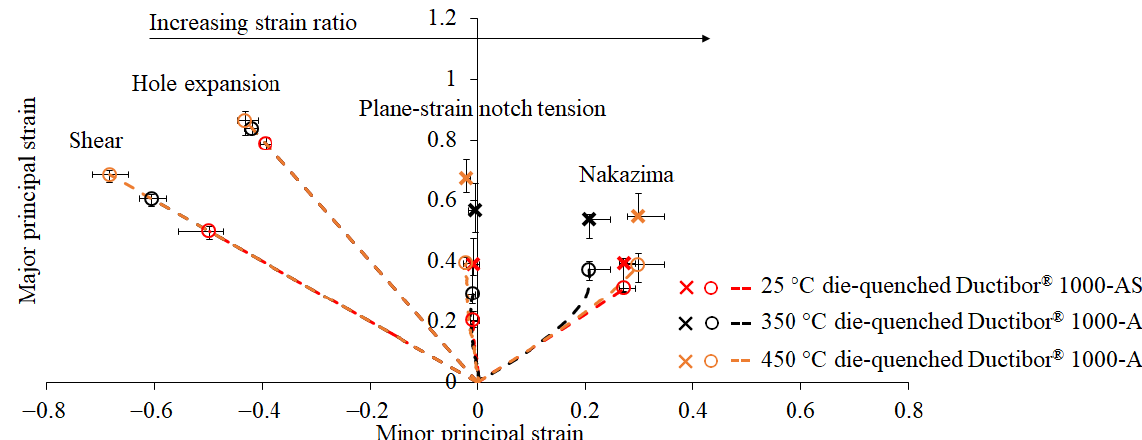
Figure 11. The measured strain paths at the fracture points of fracture-test samples of various die-quenched conditions of Ductibor ® 1000-AS during deformation. The DIC and thickness measurement-based fracture points are denoted by the “o” and “ × ” symbols, respectively, and the scatter of the measured data is displayed by the error bars. Table 4. The averaged stress triaxiality ( η ), Lode parameters ( ξ ), and strain ratios ( ρ ) at the fracture locations of fracture-test samples of various die-quenched conditions of Ductibor ® 1000-AS. Material Condition